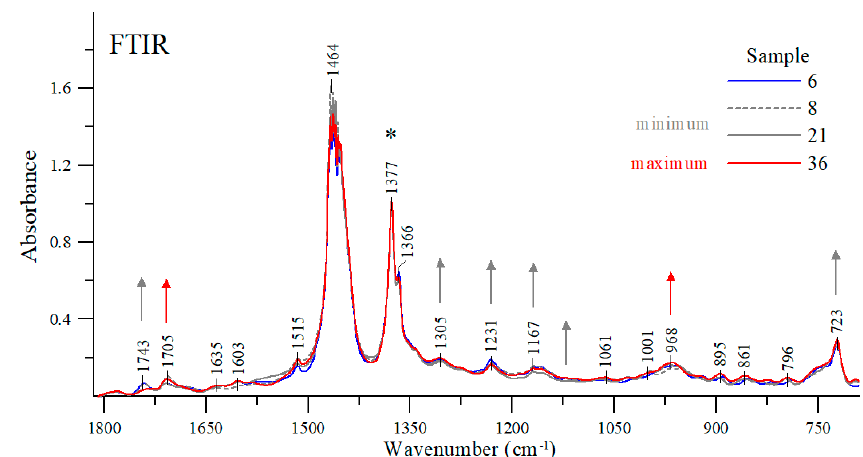
Figure 9. Exemplary FTIR spectra of the oil samples in the spectral range of 1815-690 cm − 1 . *The asterisk indicates the band at which the spectra presented were normalized. -> Arrows of the same color mark those bands that increase the intensity of vibrations, and which decrease as the viscosity changes.